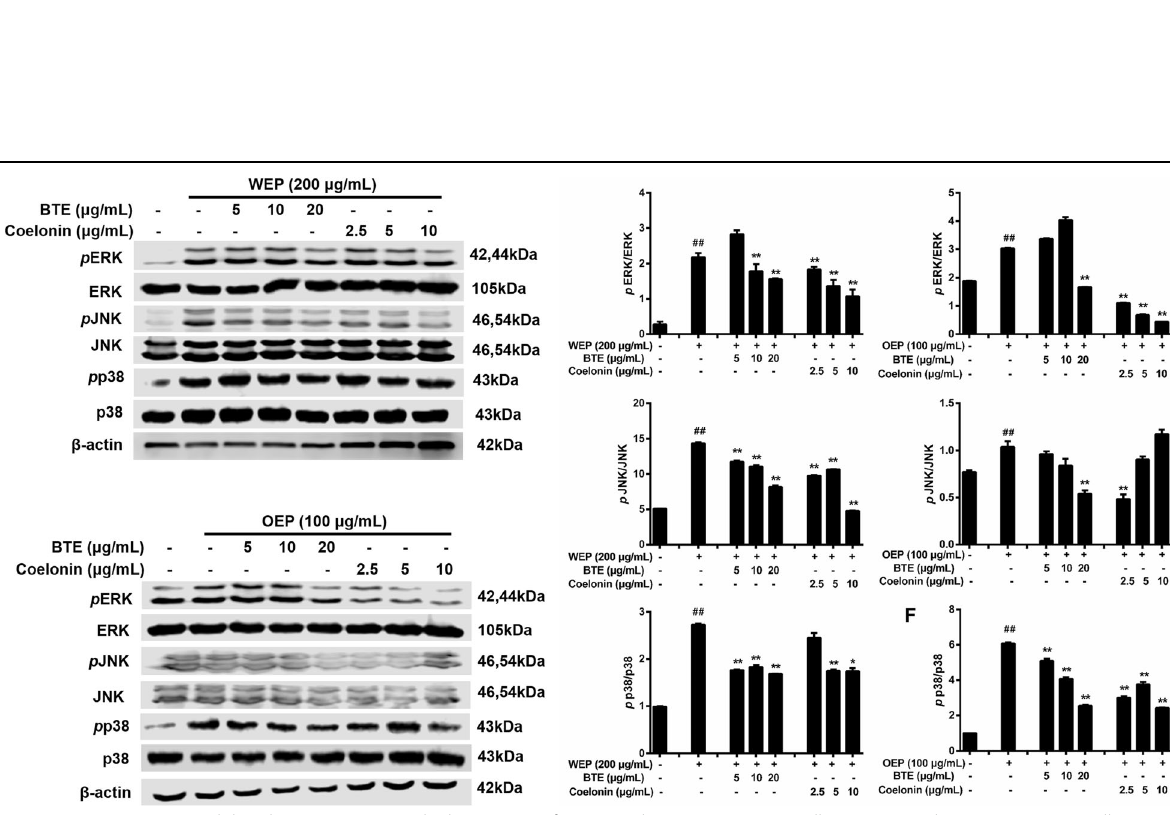
Fig. 9 EFB pretreatment inhibited PM 2.5 extracts evoked activation of MAPK pathway in RAW264.7 cells. Protein synthesis in RAW264.7 cells exposed to 200 μ g/mL WEP or 100 μ g/mL OEP, which was attenuated by BTE and Coelonin. # < 0.05, ## < 0.01 vs. control. * < 0.05, ** < 0.01 vs. model (PM 2.5 extract-only group)